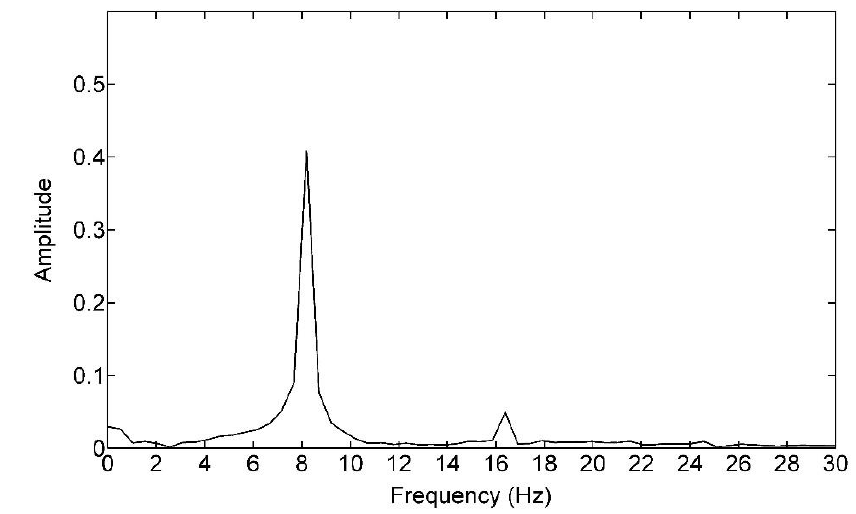
Figure 5. Spectrum of the pressure difference between the DIMT and CIMT.